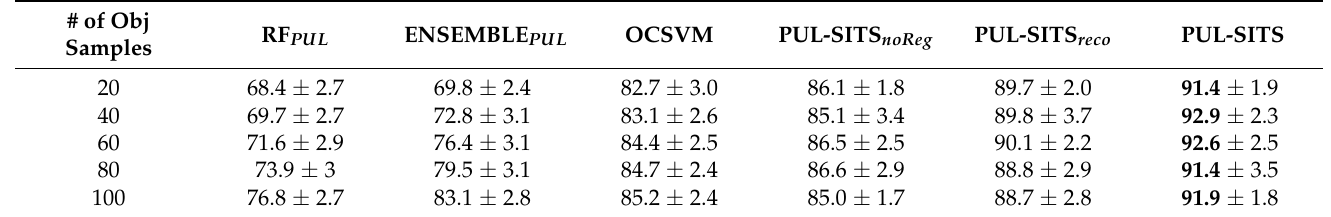
Table 9. Performances in terms of the F-Measure of the different competing strategies when the land cover class of interest (the positive class) is Forest .